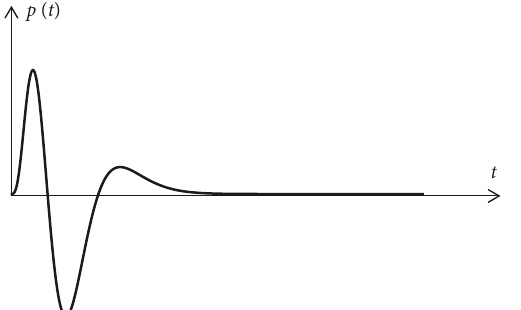
Figure 7: Wave shape of the pressure acting on the equivalent cavity produced by the explosive.